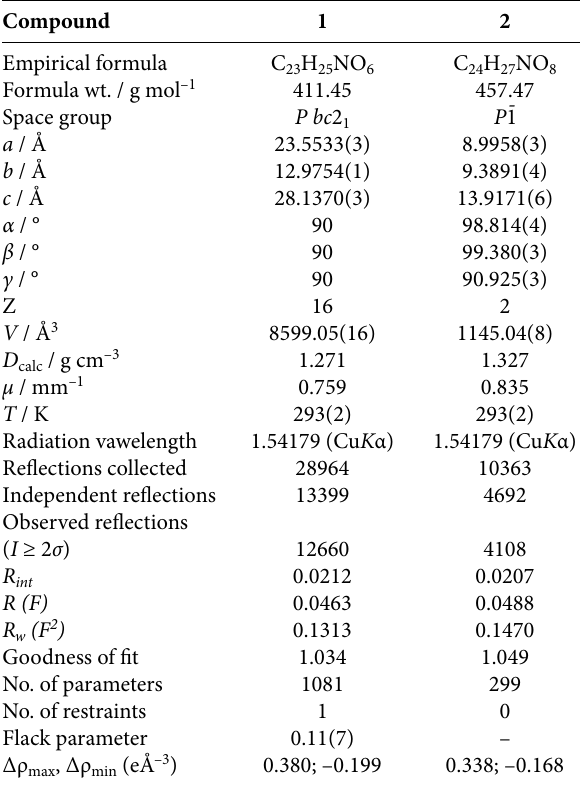
Table 1. Crystallographic data collection and structure refinement details.